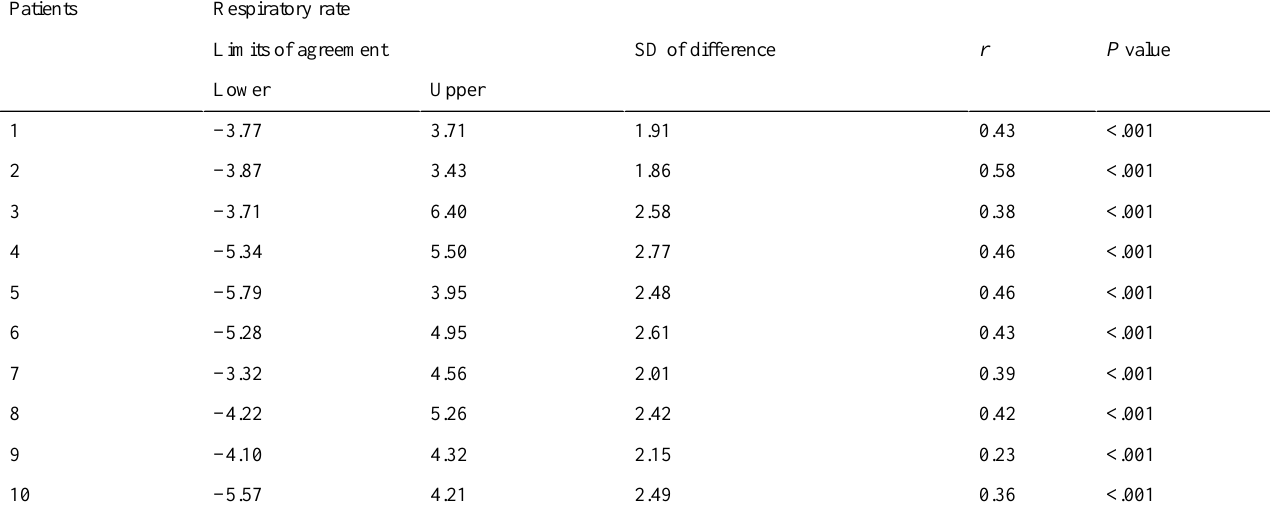
Table 5. Limits of agreement of the Bland-Altman plots, Pearson correlation coefficient, and P value for respiratory rate